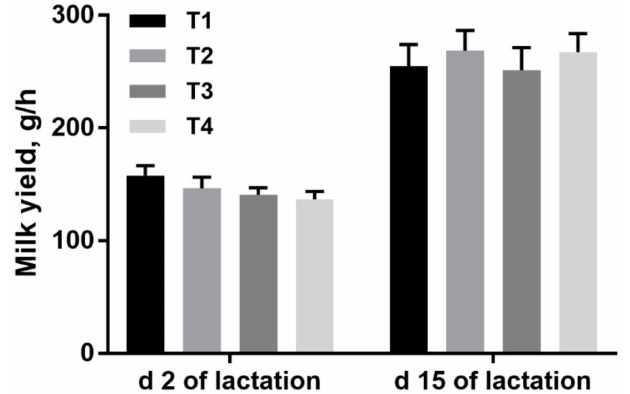
Figure 1. E ff ects of the ratio of insoluble fiber to soluble fiber in gestation diets on sow milk yield on day 2 and 15 of lactation. No treatment e ff ects and linear and quadratic e ff ects were observed in milk yield on d 2 and 15 of lactation. T1, T2, T3, and T4 were diets in which the ratios of insoluble to soluble fiber were 3.89, 5.59, 9.12, and 12.81, respectively. Values are mean ± standard error. n = 16, 15, 15, 16 for T1, T2, T3, and T4,